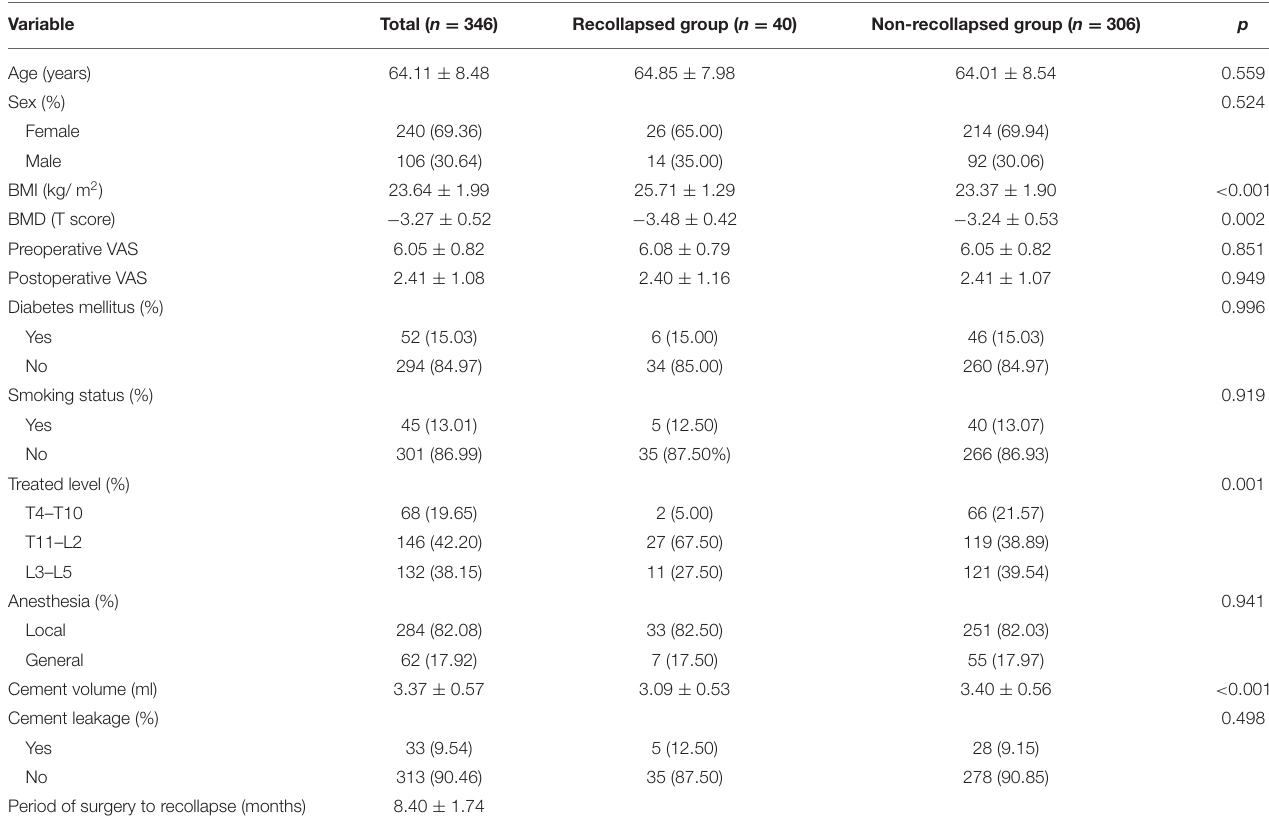
TABLE 1 | Descriptive summary of patient